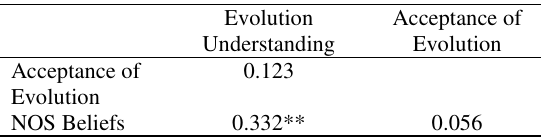
Table 3 Pearson correlations between Evolution understanding, Acceptance of Evolution and beliefs about